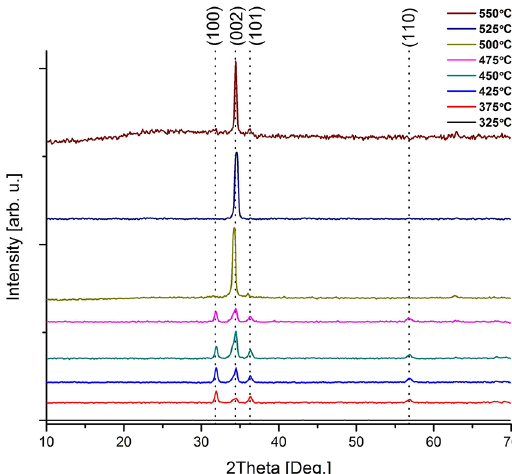
Figure 2. The XRD pattern of undoped zinc oxide thin films deposited at different substrate temperatures